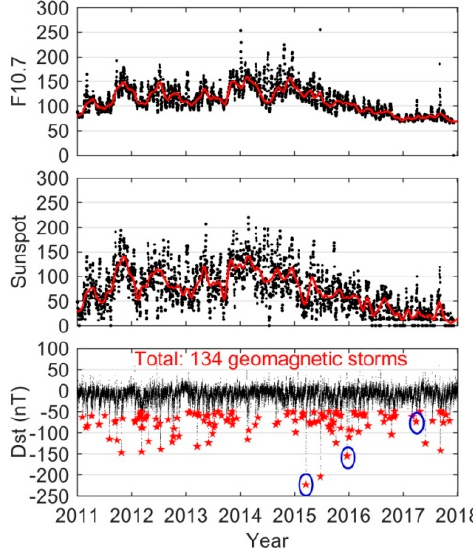
Figure 1. The variations of solar flux index F10.7, sunspot number and the geomagnetic index Dst in the solar cycle 24. The red lines represent the corresponding smoothed data and the red stars represent the geomagnetic storms.